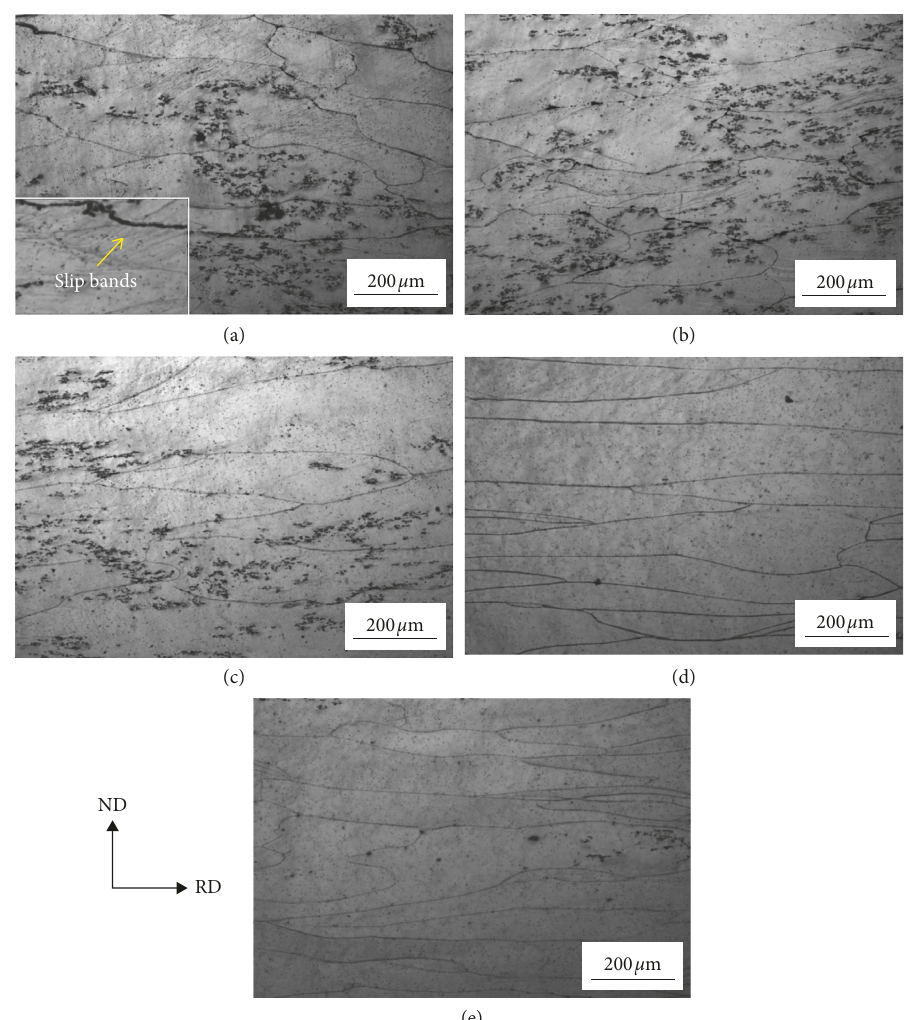
Figure 1: OM images of the hot-rolled specimen under different temperatures. (a) 100 ° S ; (b) 150 ° S ; (c) 200 ° S ; (d) 250 ° S ; (e) 300 ° S